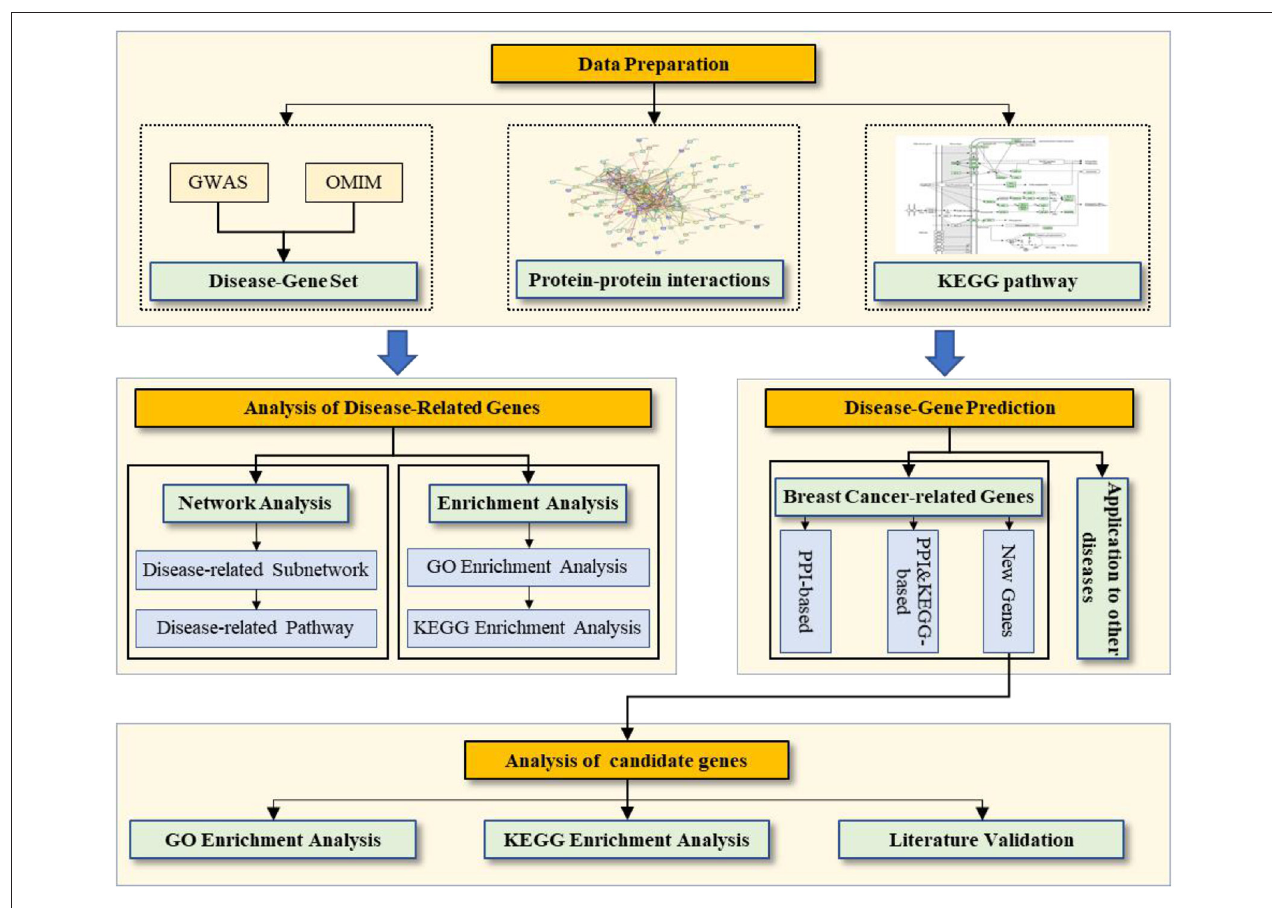
FIGURE 1 | Workflow of the work.